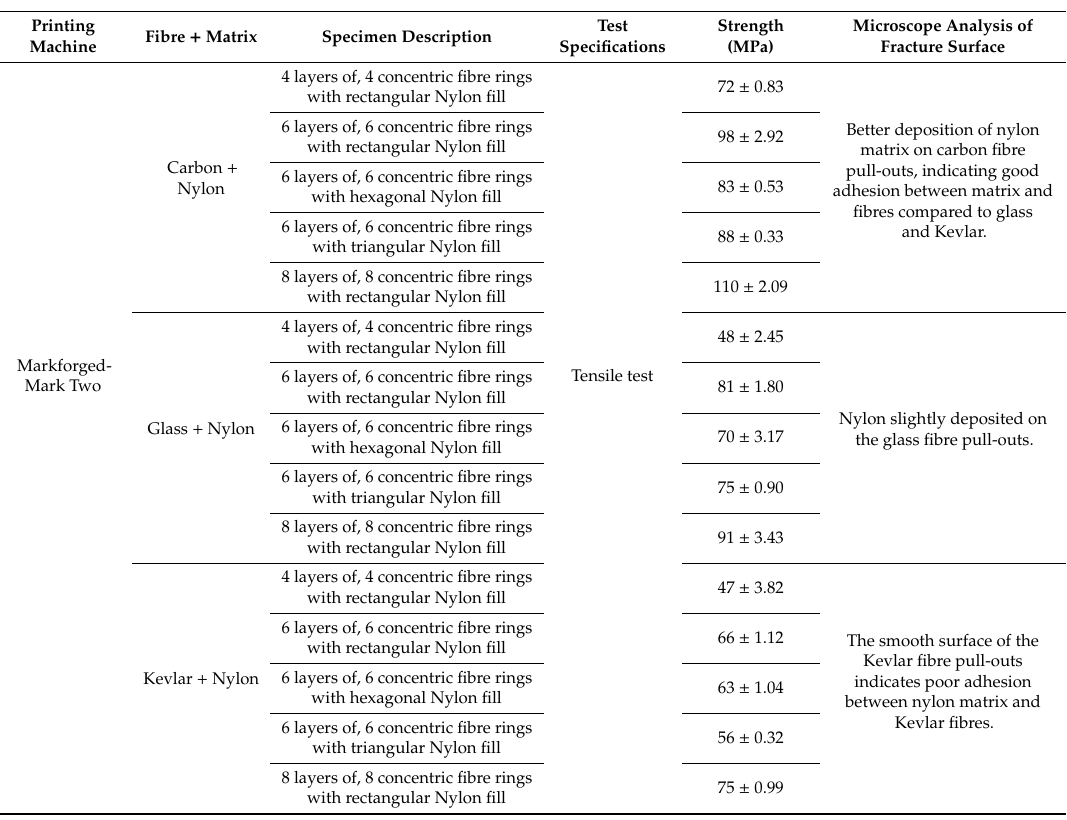
Table 3. Infill pattern, strength, modulus and microstructural analysis details